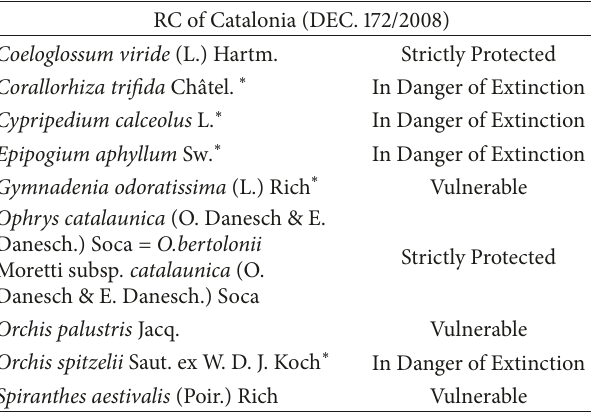
Table 13: Species included in the regional catalogue (RC) of Catalonia (DEC.